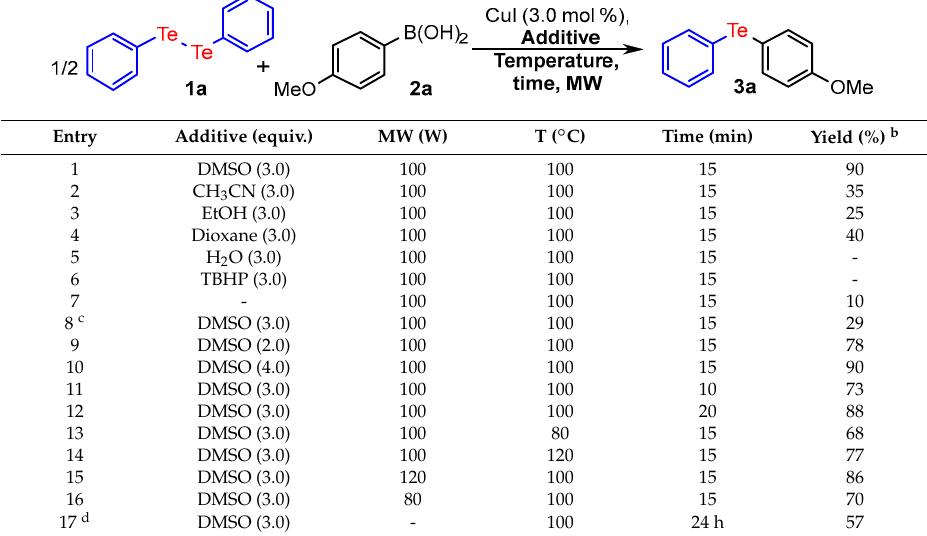
Table 2. Optimization of reaction conditions a .